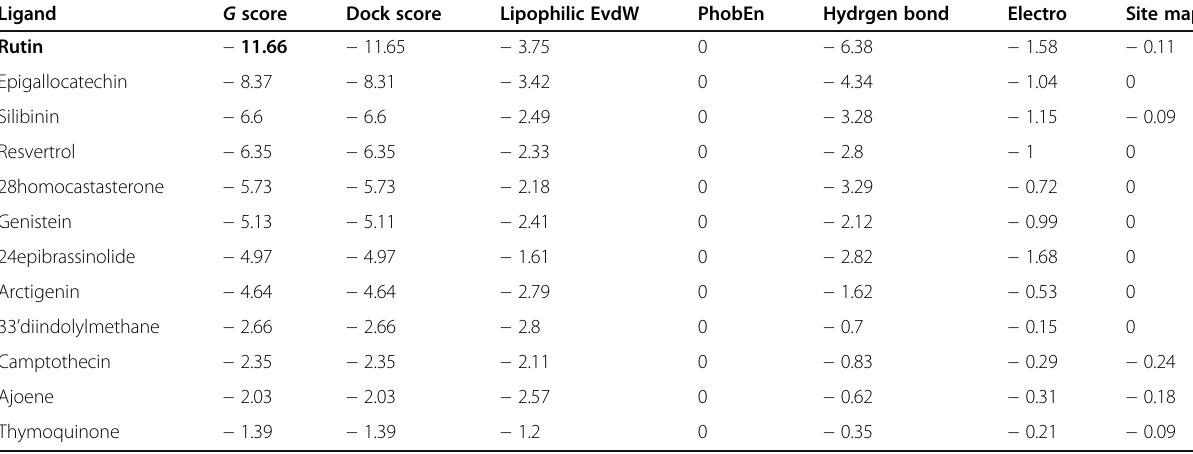
Table 6 Schrödinger maestro docking scores of ligands against ALDH18A1 Ligand